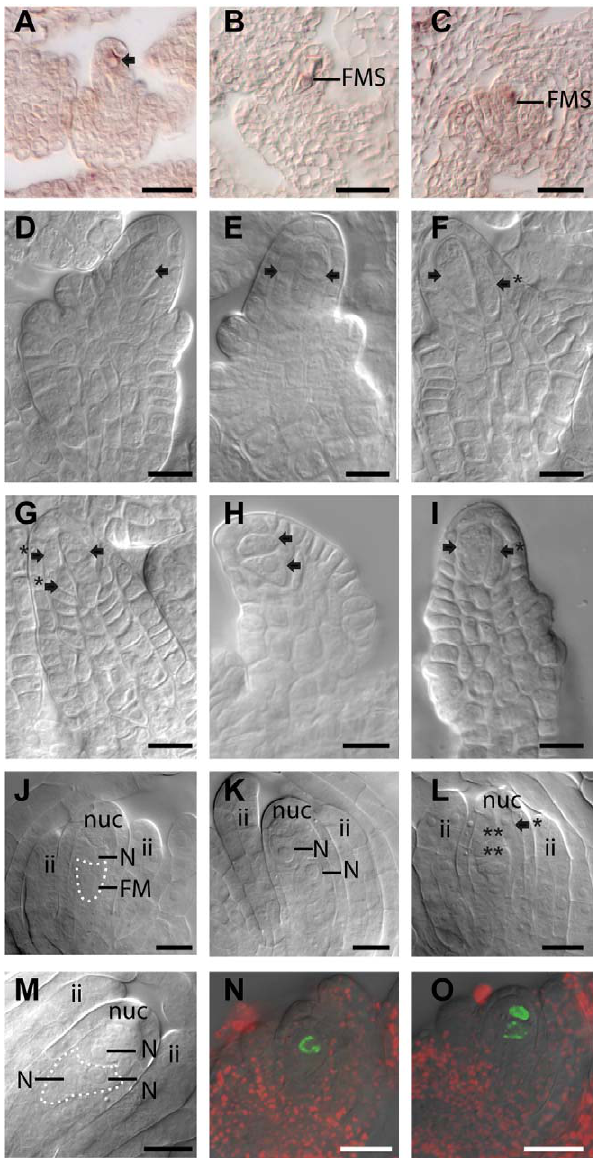
Figure 5. Analysis of MEM expression and mem-1 and mem-2 mutant phenotypes during megasporogenesis. (A–C) In situ hybridization showing expression of MEM in the MMC (A), the degenerating tetrad (B), and the functional megaspore (B, C) in wild- type plants using an antisense probe targeting MEM . (D–I) Differenti- ation of MMCs in ovules of heterozygous mem-1/MEM (D, H, I) and mem-2/MEM (E, F, G) mutant plants. In developing ovules, either one normally differentiated MMC (D), two MMCs (E, H), or an MMC with one or more smaller unusual adjacent cells were observed (F, G, I). (J–M) Two gametophytic cells with FMS characteristics were often observed at the FMS stage (J, K) or after the first mitotic division (M), or abnormal cells were seen adjacent to the degenerated megaspores (L) in ovules of mem-1/MEM (J) and mem-2/MEM (K–M) mutant plants. (N, O) Analysis of H2B-YFP expression under the control of the AKV promoter in plants heterozygous for the mem-2 allele. YFP signals were studied by confocal microscopy. The AKV cell identity marker indicates one gametophytic cell in the wild-type ovule (N) and two gametopyhtic cells in the mutant ovule (O) at the FMS developmental stage. Scale bars are 20 m m (A–C, N, O) and 10 m m (D–M) (arrows point to MMC, an arrow with an asterisk indicates abnormal adjacent cell, two asterisks denote degenerated megaspores, ii inner integuments; nuc, nucellus; N, nucleus).